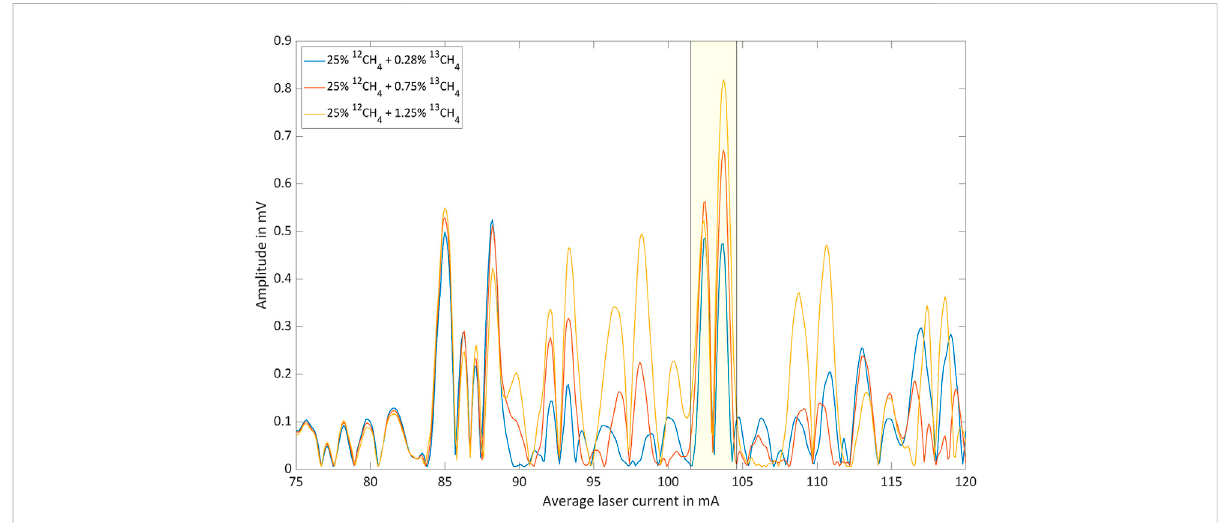
FIGURE 6 Photoacoustic signal as function of the average laser current for 25% 12 CH 4 with three different 13 CH 4 shares in nitrogen.